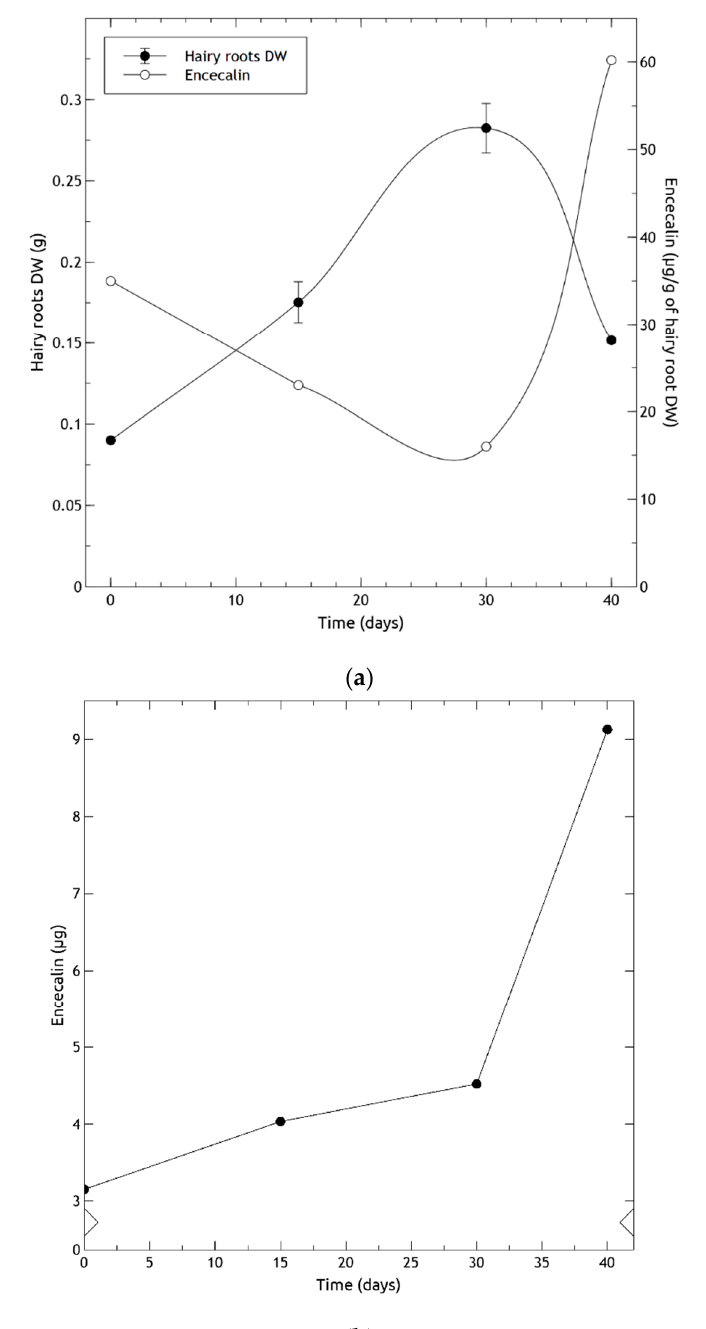
Figure 9. Encecalin production in six months old hairy roots of Helianthella quinquenervis obtained by co ‐ culture; ( a ) Growth of hairy roots (•) and encecalin quantification (o); ( b ) encecalin production per explant obtained by multiplying the weight of explants (in grams) by their quantification per gram. DW data represent average ± SD of three measurements.